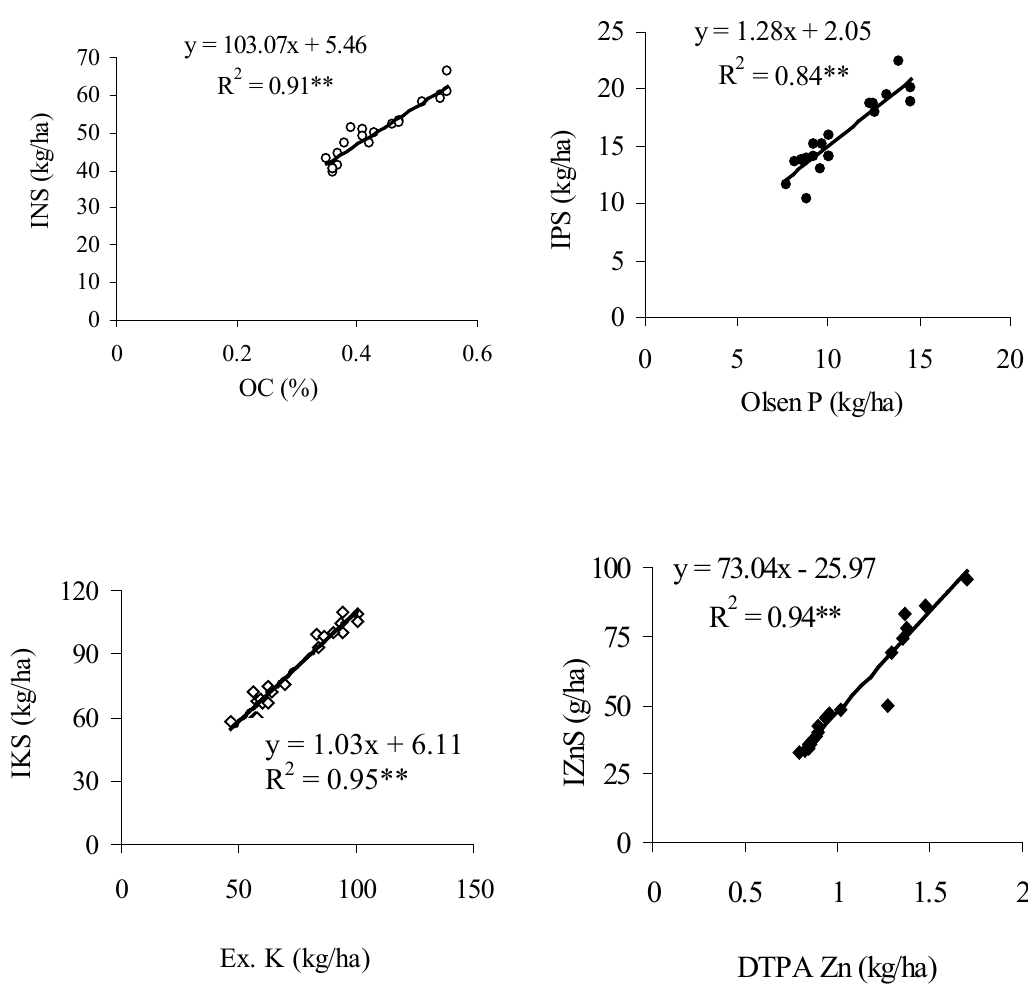
FIGURE 1. Relationship between indigenous N, P, K, and Zn with organic C, Olsen P, exchangeable K, and DTPA-Zn, respectively. Data are based on wheat experiments conducted at 20 sites in the Nadia district of West Bengal during the years 2001–2002 and